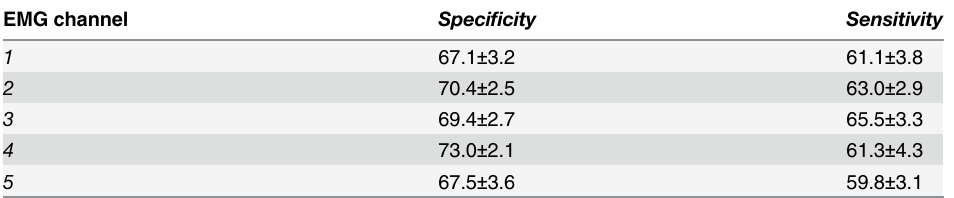
Table 2. Mean sensitivity and specificity measures (%) for each EMG channel with a 95% confidence